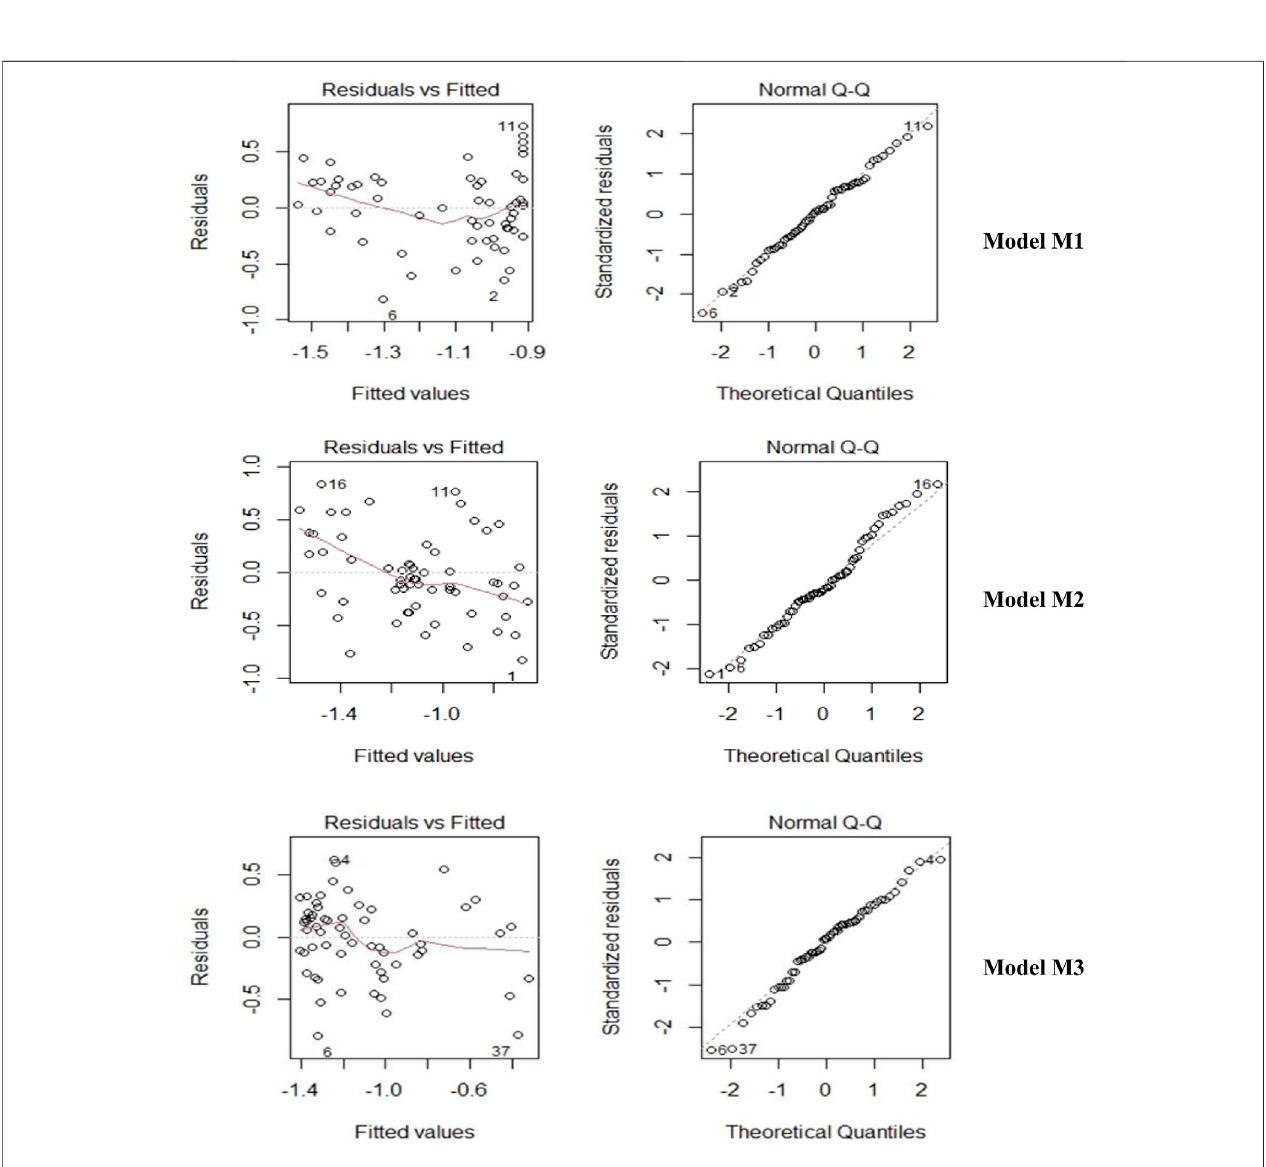
FIGURE 8 | Residual plot and normal QQ plot.